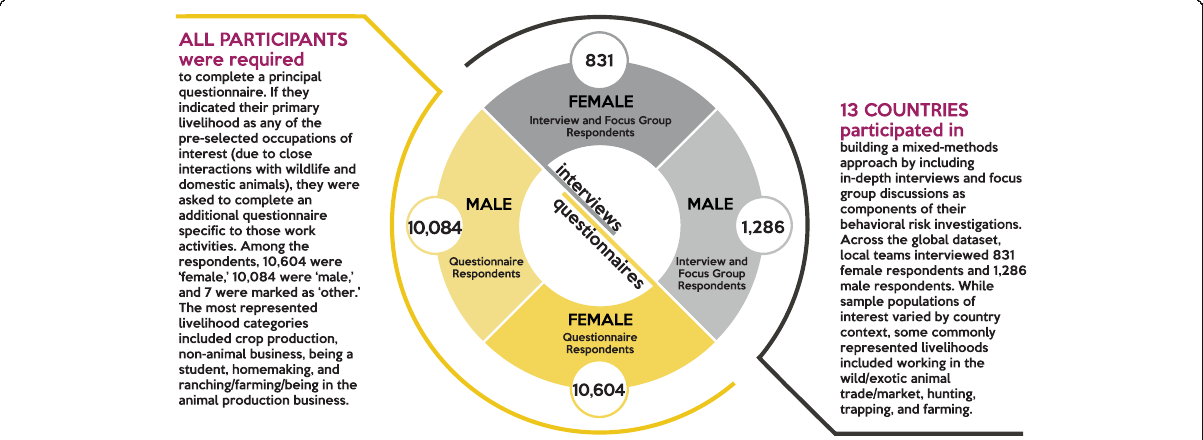
Fig. 2 Implementation of questionnaires, ethnographic interviews, and focus group discussions